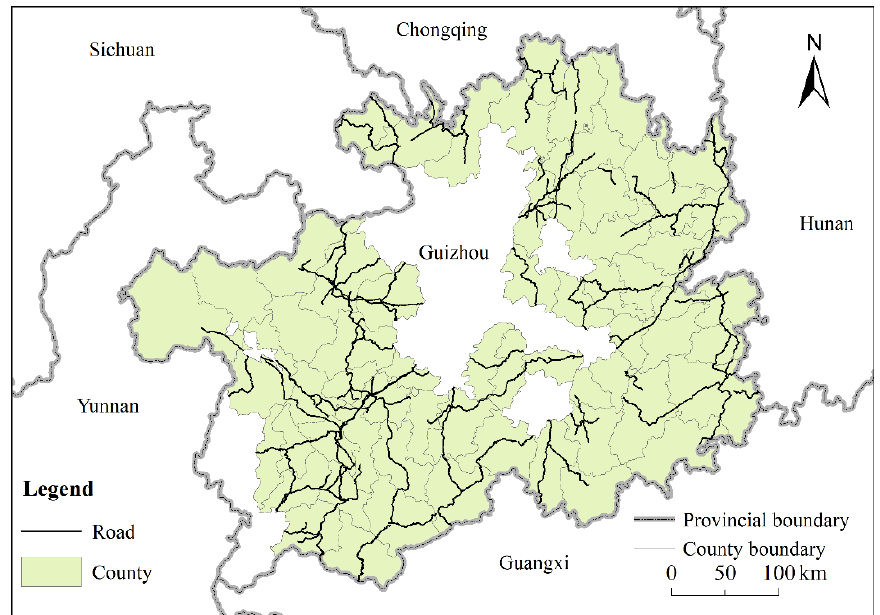
Figure 4. Spatial distribution of main road within study area.